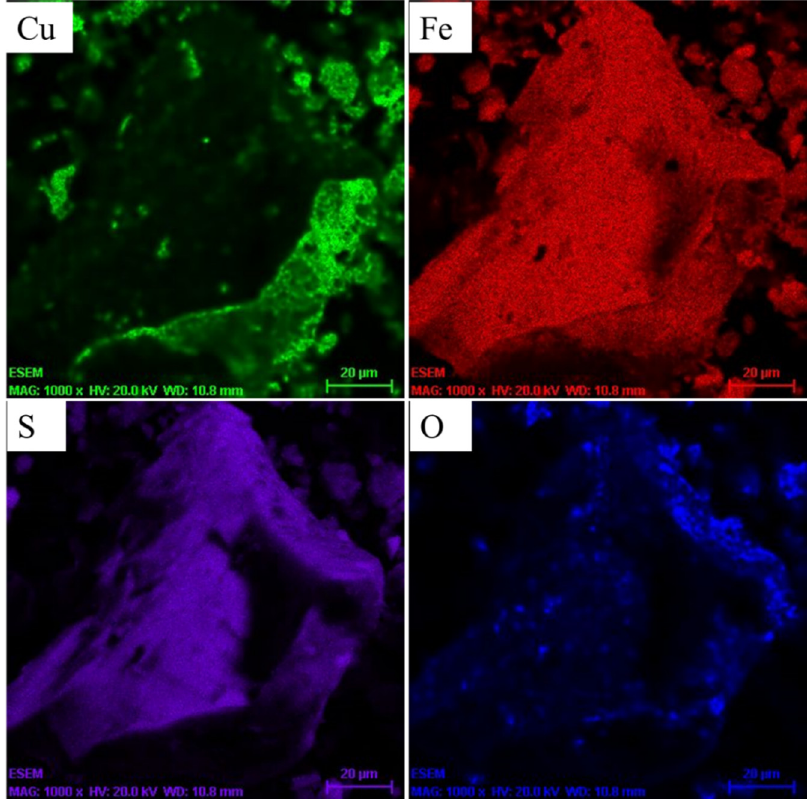
Figure 3. EDS mapping of the chalcopyrite-bearing ore.